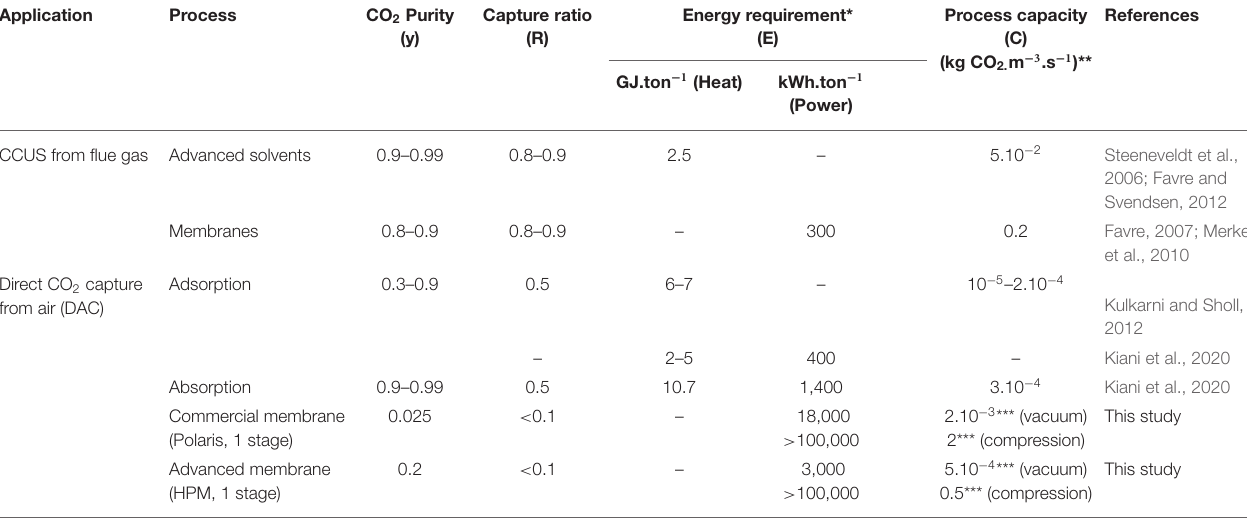
TABLE 3 | Tentative comparison of key performance indicators of CCUS and DAC processes, based on existing studies. Application